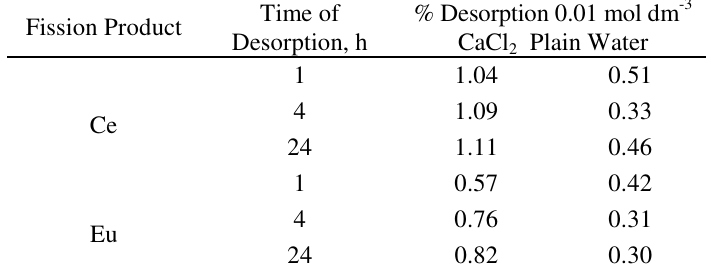
Table 3. Effect of time on the desorption of Cerium and Europium using 0.01 mol dm -3 CaCl and water as desorbent 2